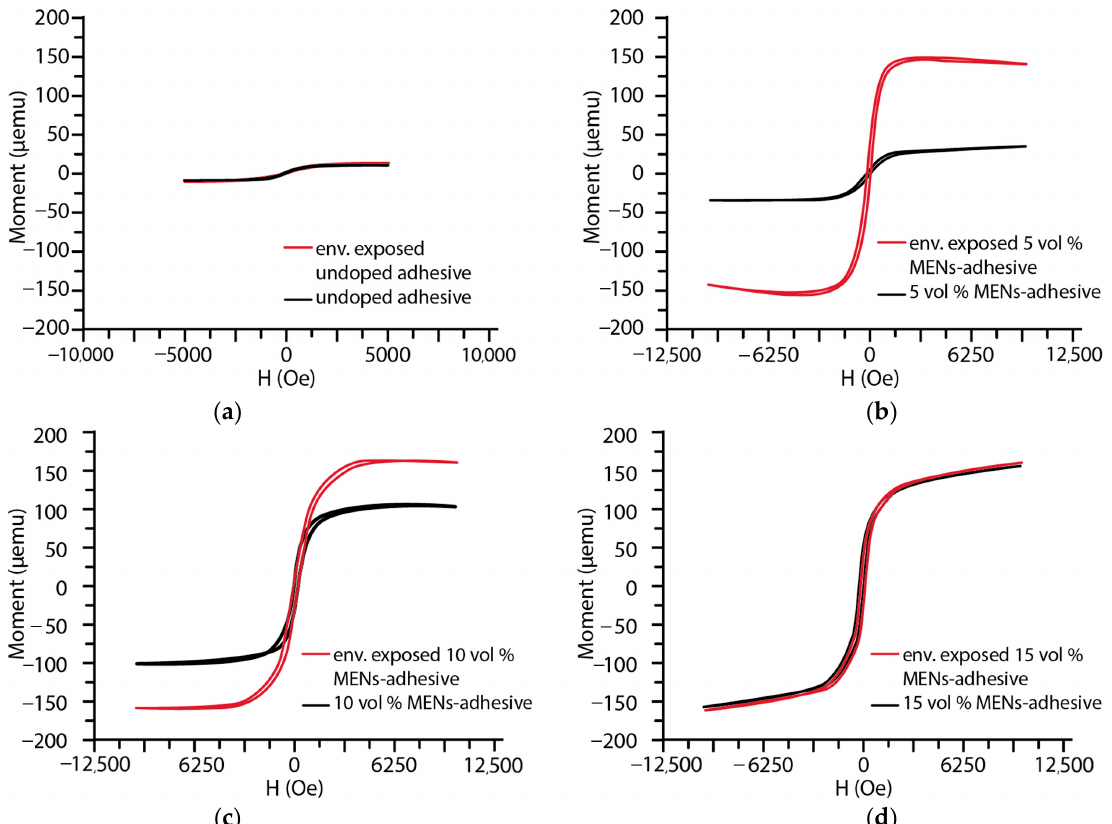
Figure 9. Magnetic signatures before and after environmental exposure of ( a ) 0 vol% concentration, ( b ) 5 vol% concentration, ( c ) 10 vol% concentration, and ( d ) 15 vol% concentration. ( b ) 5 vol% concentration, ( c ) 10 vol% concentration, and ( d ) 15 vol%